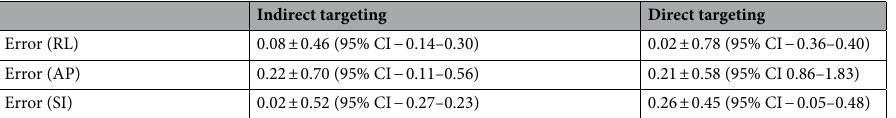
Table 1. Detailed results of Bland-Altaman analysis with mean error of the differences between the direct and indirect coordinates compared to the clinically effective